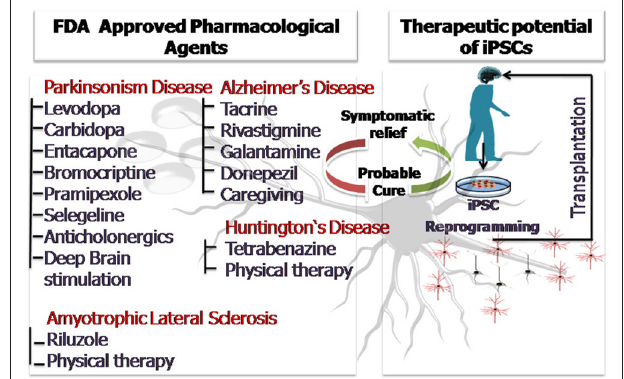
FIGURE 3 | The diagrammatic illustration of possible therapeutic strategies against the prevalent neurodegenerative disorders (ND). The nature of ND is progressive in nature and limits the clinical utility of pharmacological drugs which provide only symptomatic relief. Stem cell therapy and iPSC technology could harness neurorestorative and neuro regenerative relief for the patients suffering from neurodegenerative disorders as well as pave way for a possible cure in